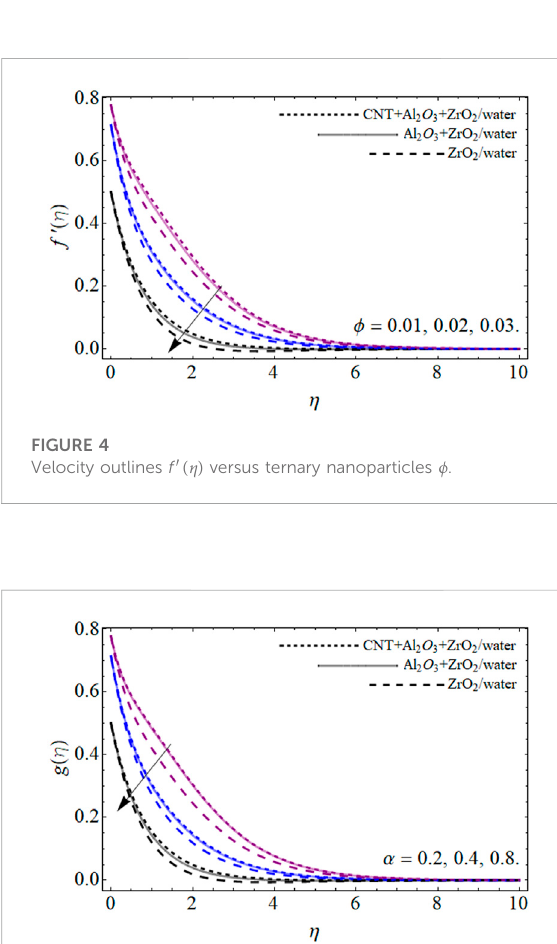
FIGURE 5 Velocity outlines g ( η ) versus velocity slip factor α .